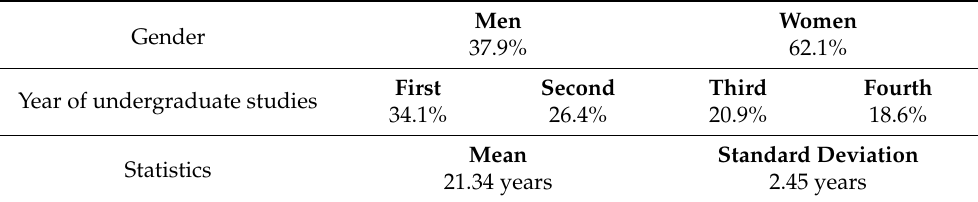
Table 2. Sociodemographic characteristics of the sample.